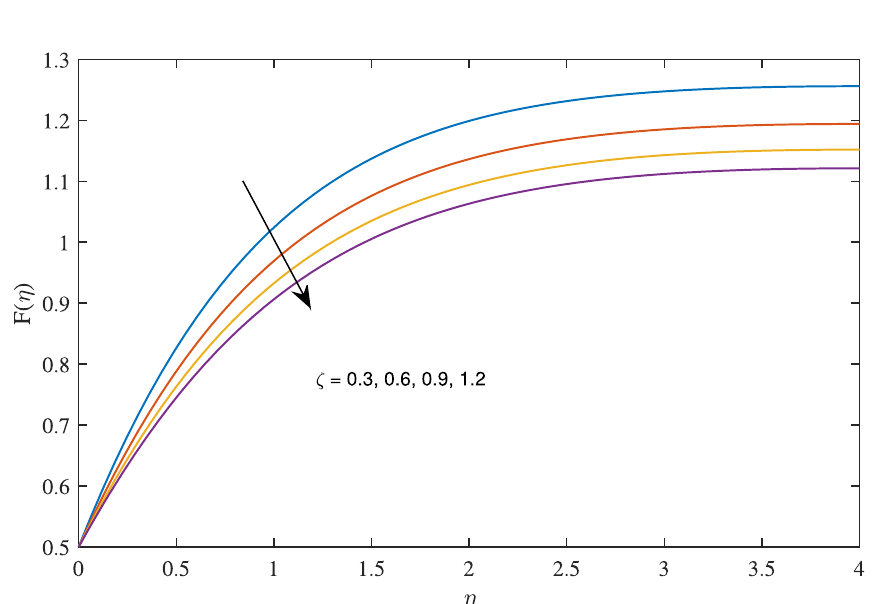
Figure 9. Effects of variation of suction parameter w 0.1 and Pr 0.2 , φ N rd = =